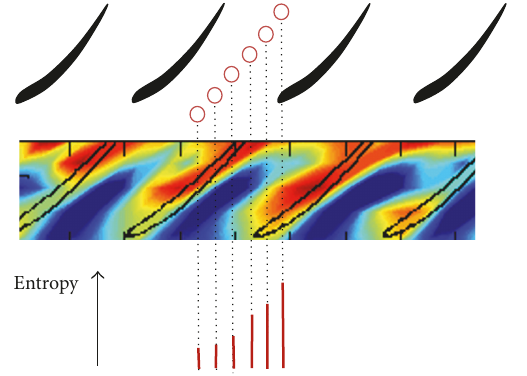
Figure 17: Entropy as description for current state of flow within a blade passage.